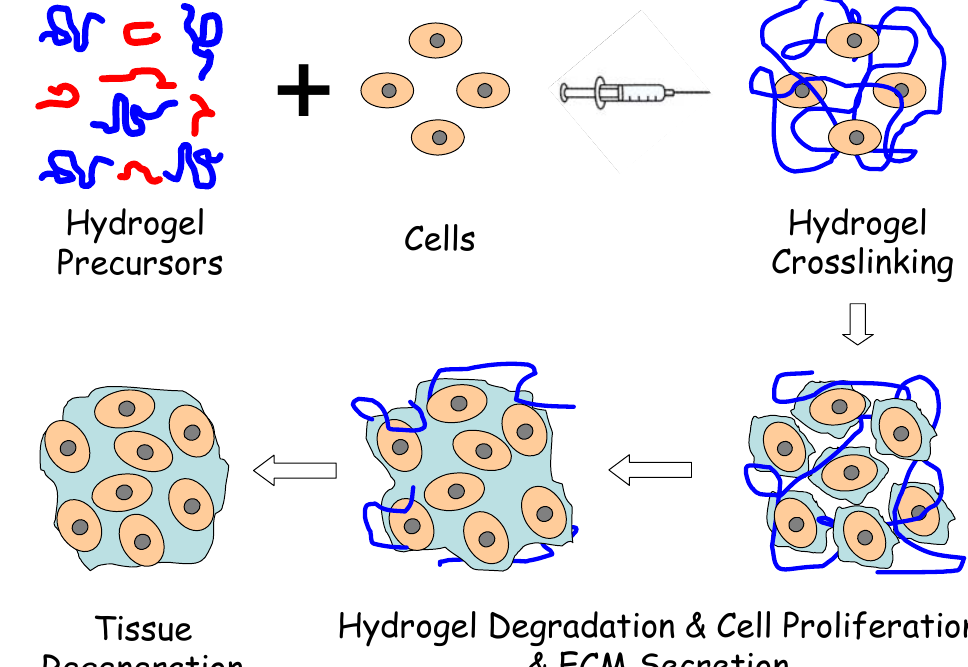
cells secrete ECM. This strategy enables the clinician to transplant the cell, growth factor and hydrogel combination in a minimally invasive